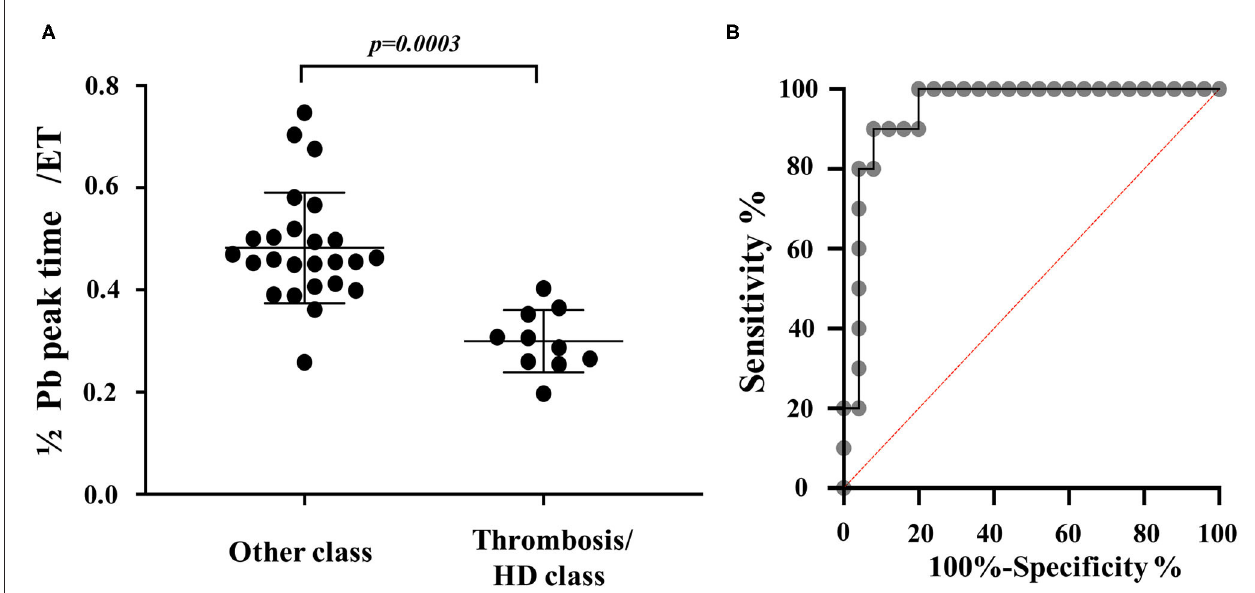
FIGURE 5 | PAWR indices in dogs grouped in different categories. (A) , Comparison of 1/2Pb peak time/ejection time between dogs with suspected PH and no definitive diagnosis and Dogs with suspected PH due to thrombosis/heartworm disease. (B) , Receiver-operating characteristic (ROC) curves of 1/2Pb peak time/ejection time for distinguishing between dogs with suspected PH and no definitive diagnosis and Dogs with suspected PH due to thrombosis/heartworm disease among dogs with PH. PH other class, dogs with suspected PH and no definitive diagnosis. PH thrombosis/HD class, PH due to thrombosis/heartworm disease. PH, pulmonary hypertension; Pb, backward pressure (Pulmonary artery wave reflection); ET, ejection time; HD, heartworm disease.